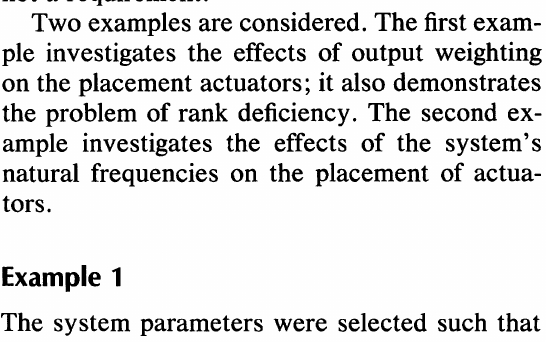
Table 1. System Characteristics for Example 1 ml = m2 = m3 = m4 = mS = 3; m6 = m7 = 1.2;